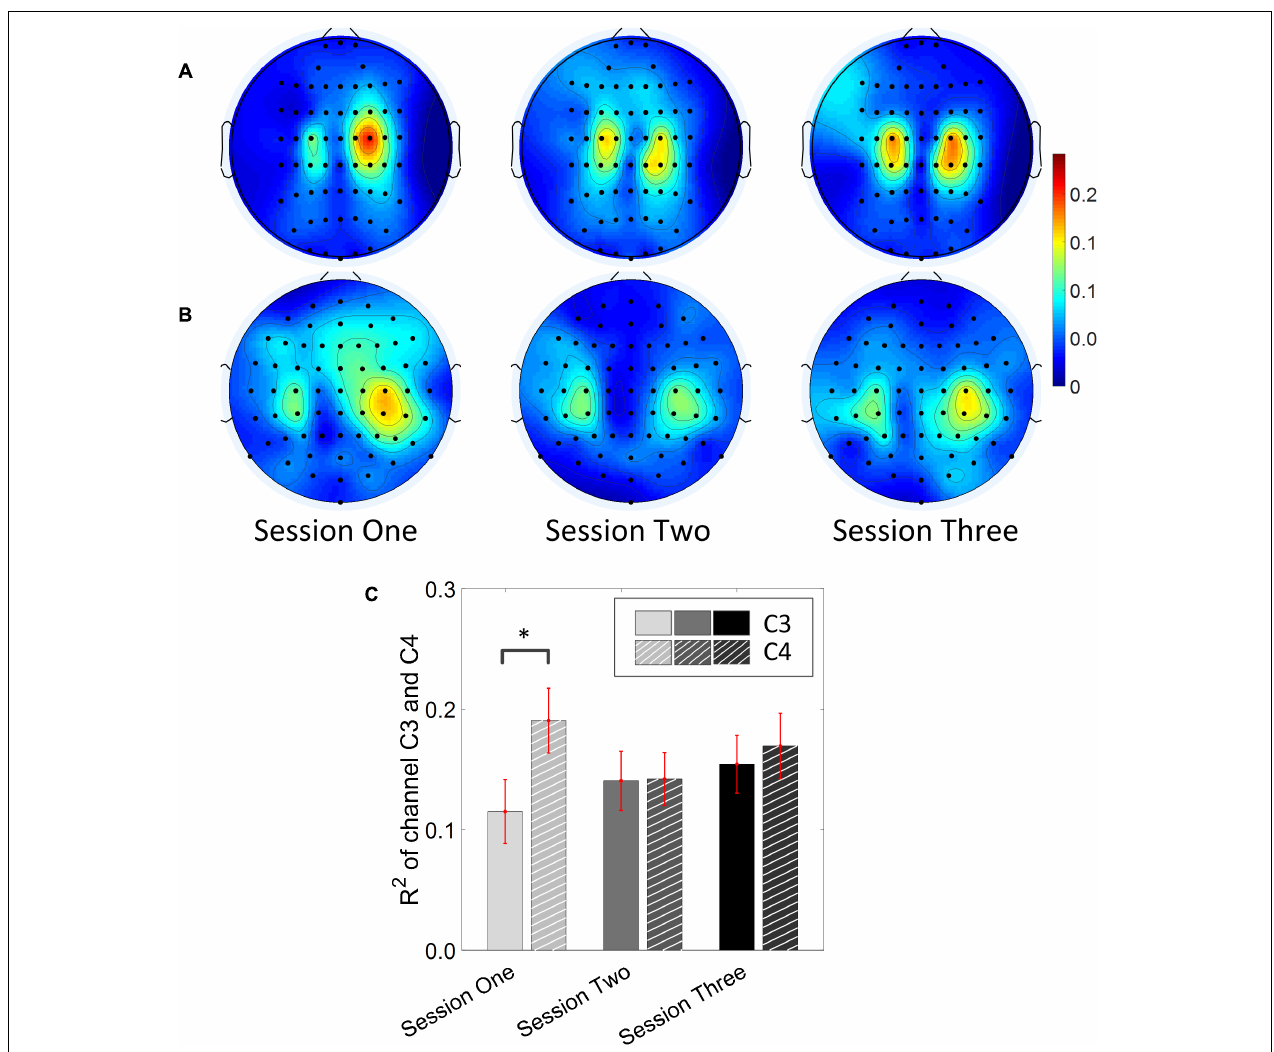
FIGURE 4 | R 2 value topography maps and its statistics. Only the hit trials are used for the calculation of R 2 values. (A) Topography of group average R 2 value across the three training sessions for subjects using Neuroscan SynAmps RT acquisition system ( N = 28). (B) Topography of group average R 2 value across the three training sessions for subjects using Biosemi Active Two acquisition system ( N = 14). (C) R 2 value of channel C3 and C4 across the three training sessions. The statistical analysis revealed that there is significant difference of R 2 value between channel C3 and C4 on the first training session ( p = 0.04). ∗ p <